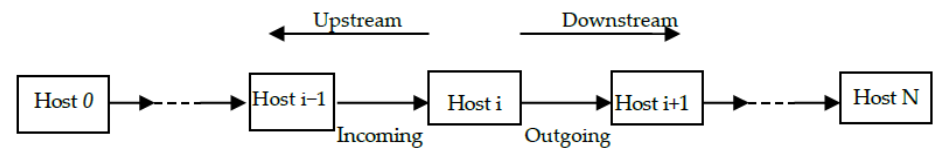
Figure 1. A Sample Connection